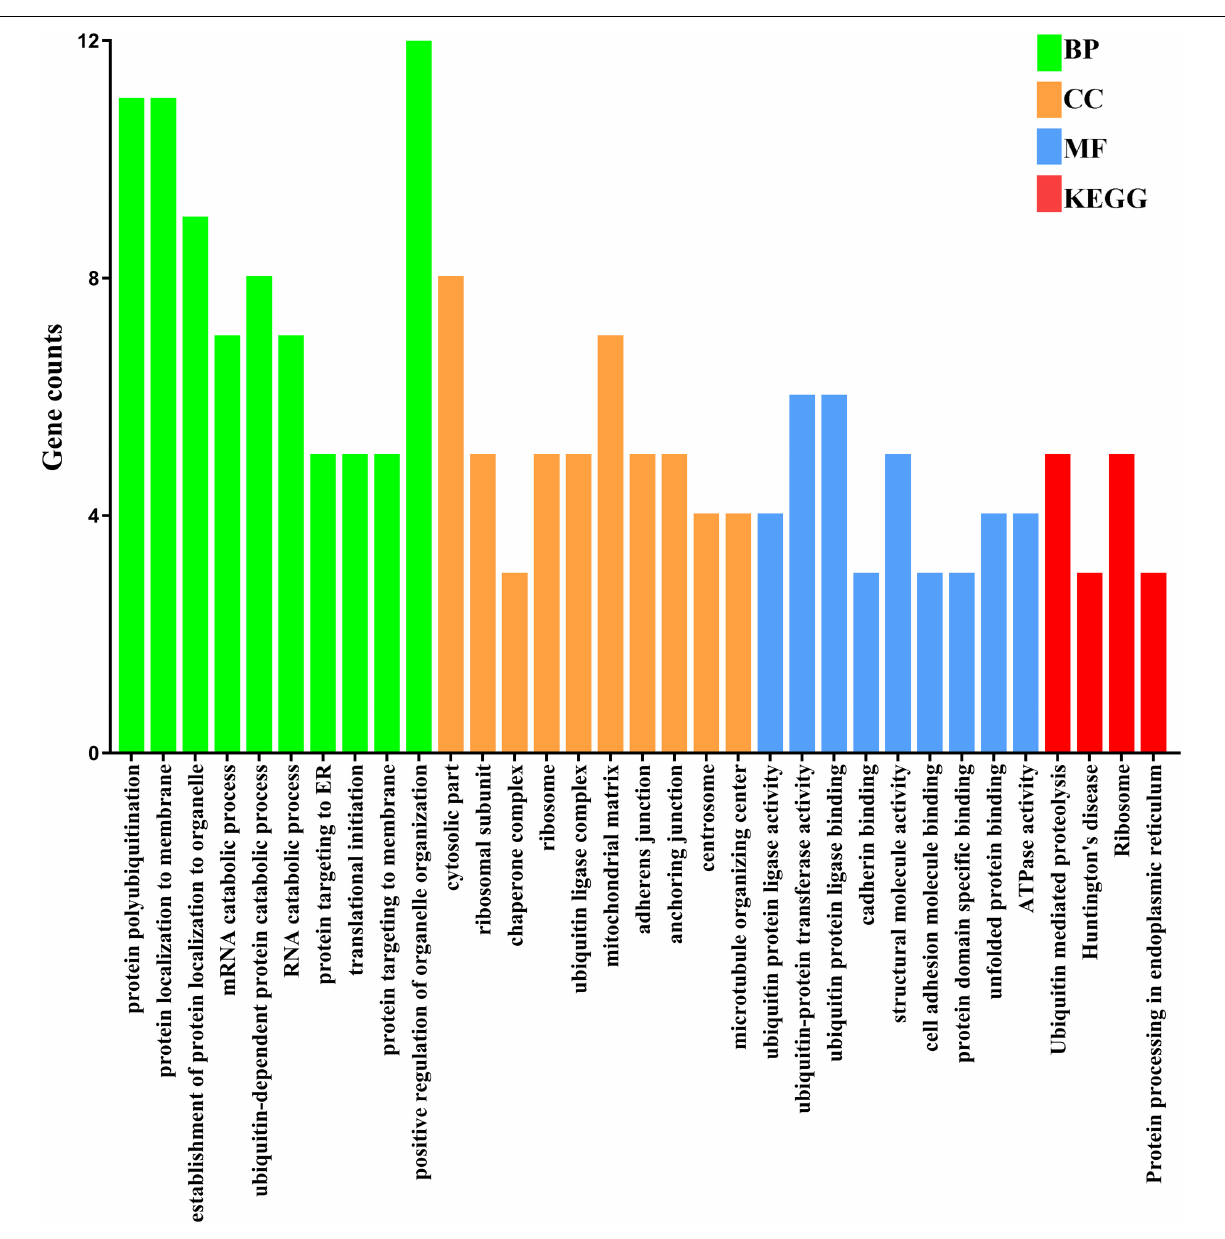
Frontiers in Genetics |